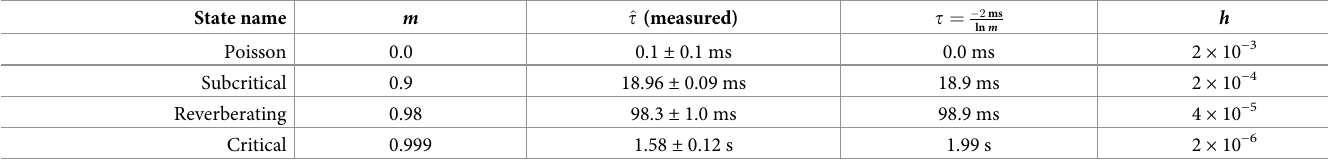
Table 1. Parameters and intrinsic timescales of dynamic states. All combinations of branching parameter m and per-neuron drive h result in a stationary activity of 1 Hz per neuron. Due to the recurrent topology, it is more appropriate to consider the measured autocorrelation time ^ t rather than the analytic timescale τ